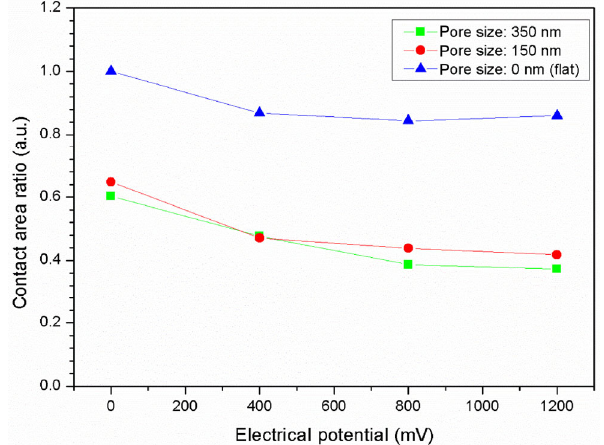
Fig. 6 Contact area ratio versus applied electric potential from metallic porous nanostructures with various pore